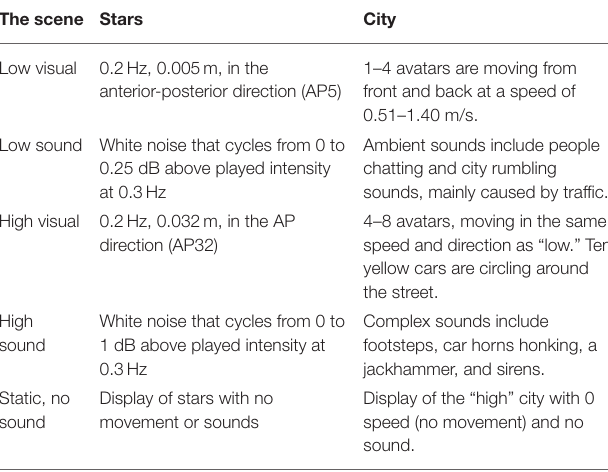
TABLE 1 | Description of the auditory and visual stimuli in each scene. The scene